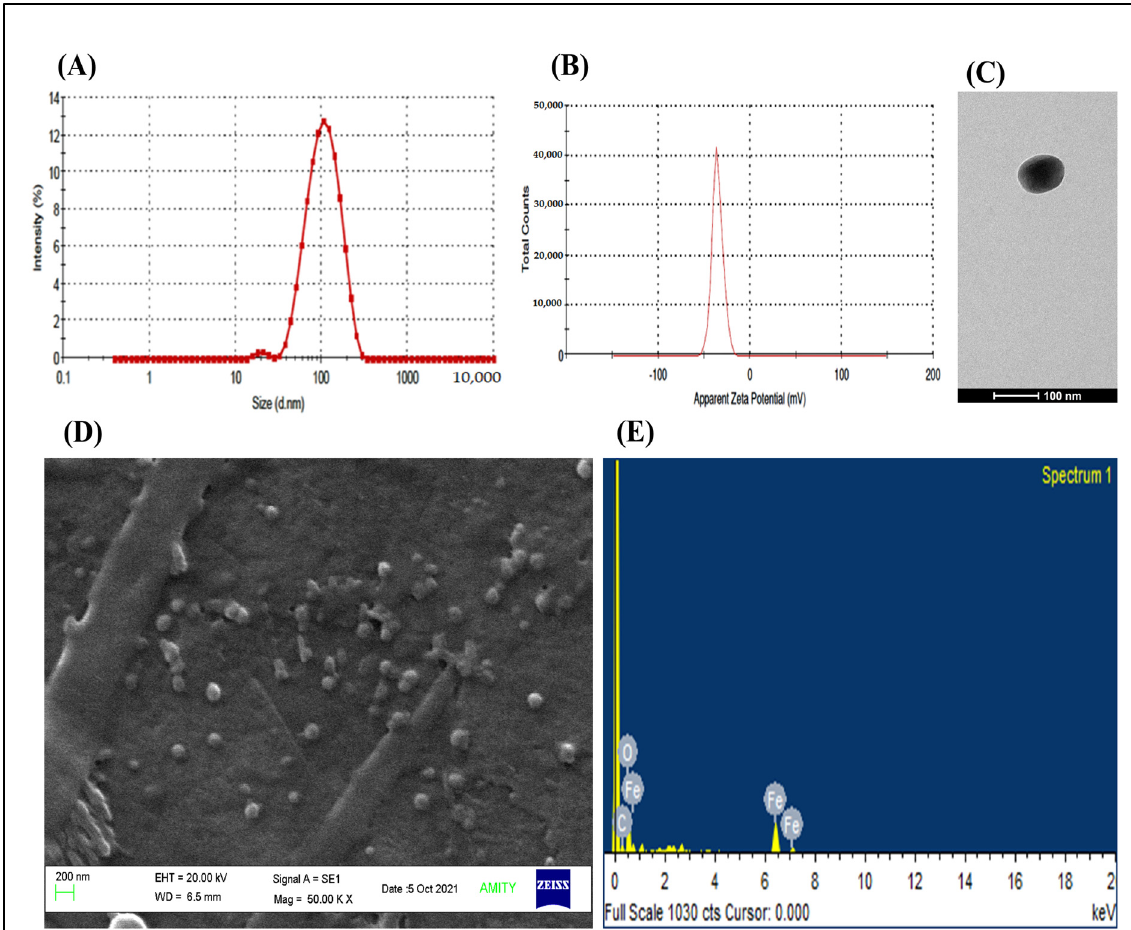
Figure 2. Characterizations of green synthesized TMX-conjugated BSA-coated SPIONs. ( A ) Particle size (hydrodynamic diameter) distribution profile of BSA-SPIONs-TMX. ( B ) Zeta potential distribution profile of BSA-SPIONs-TMX. ( C ) TEM image of BSA-SPIONs-TMX (scale bar 100 nm). ( D ) SEM image of BSA-SPIONs-TMX (scale bar 200 nm). ( E ) EDX analysis of BSA-SPIONs-TMX using